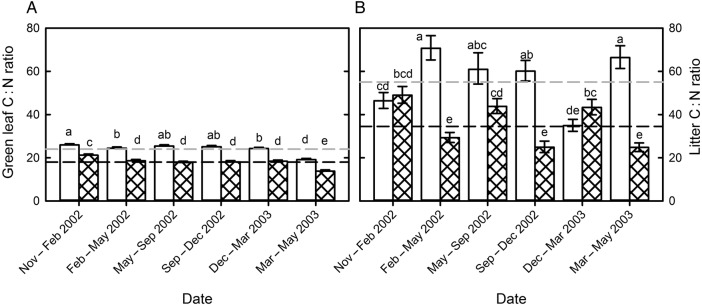
Effect of clipping frequency (open bar = infrequent, hashed bar = frequent) on C : N ratios of (A) green leaf material and (B) litter, through time averaged across CO2 and warming treatments. Dashed line indicates overall mean across dates, CO2 and warming treatment for each clipping frequency, infrequent (grey) and frequent (black). Different letters indicate statistically significant differences between C : N ratios at P < 0.05 using Student's t LSD test.